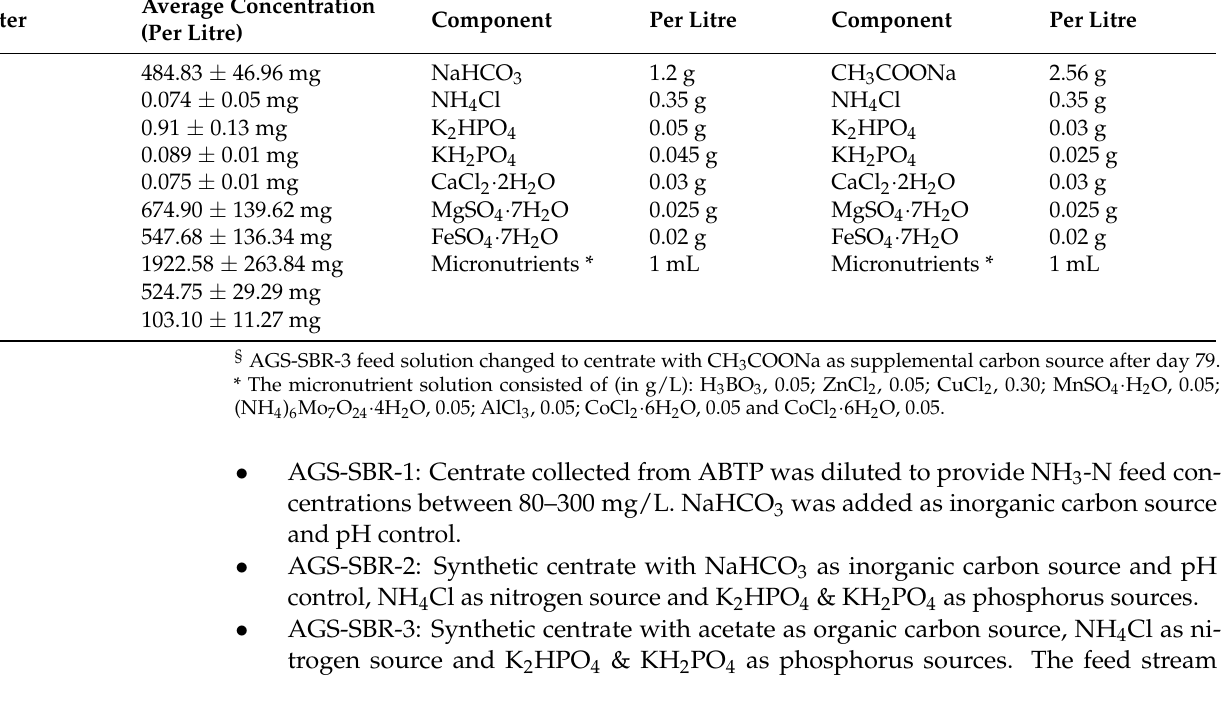
Figure 2. Sludge Volume Index (SVI 30 ) for ( a ) AGS-SBR-1, ( b ) AGS-SBR-2, and ( c ) AGS-SBR-3; MLSS concentration and MLVSS/MLSS ratio for ( d ) AGS-SBR-1, ( e ) AGS-SBR-2, and ( f ) AGS-SBR-3. Table 5. Characteristics of centrate and synthetic centrate used for AGS-SBR-1, 2 & 3.